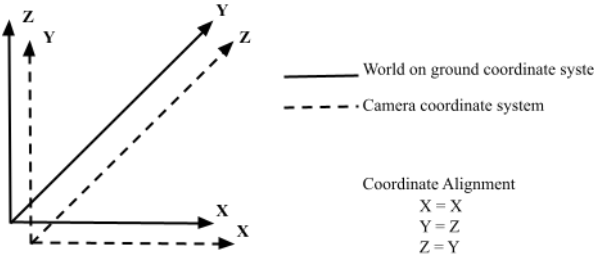
Figure 4. Alignment of world and camera coordinate